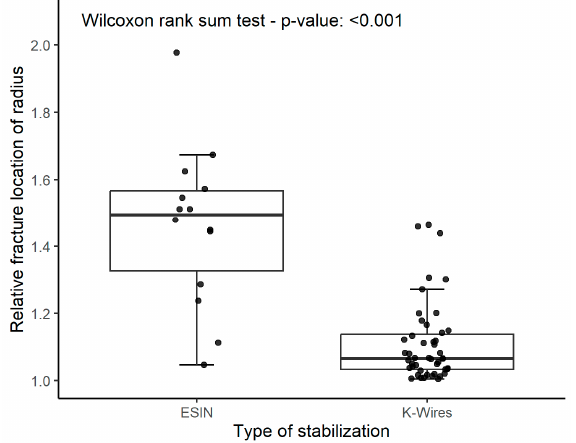
Figure 5. The boxplot graph shows that ESIN was significantly more often used in proximal frac-